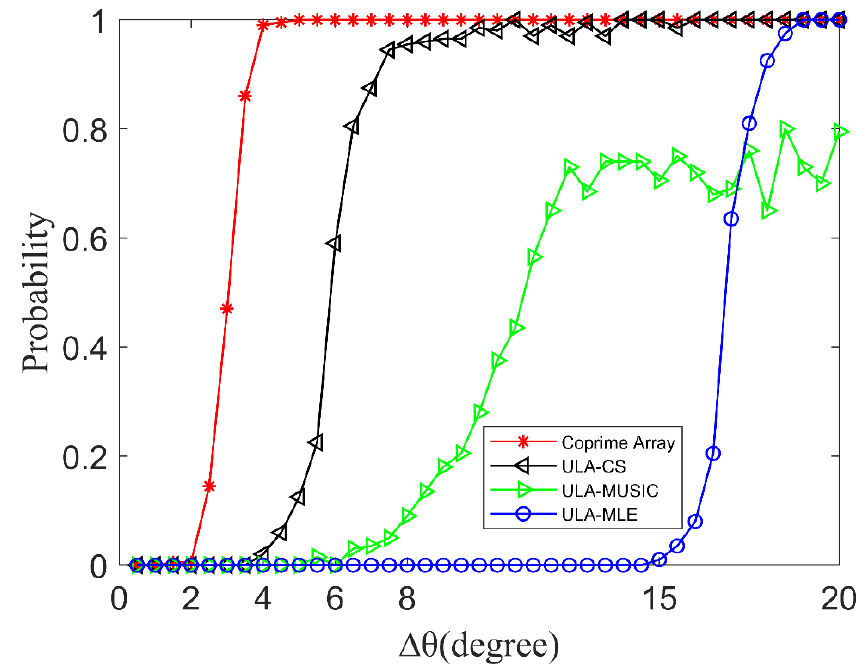
Figure 7. The relationship between the probability that can be correctly estimated and the direct- signal DOA difference between two CCBSs. DOA difference between two